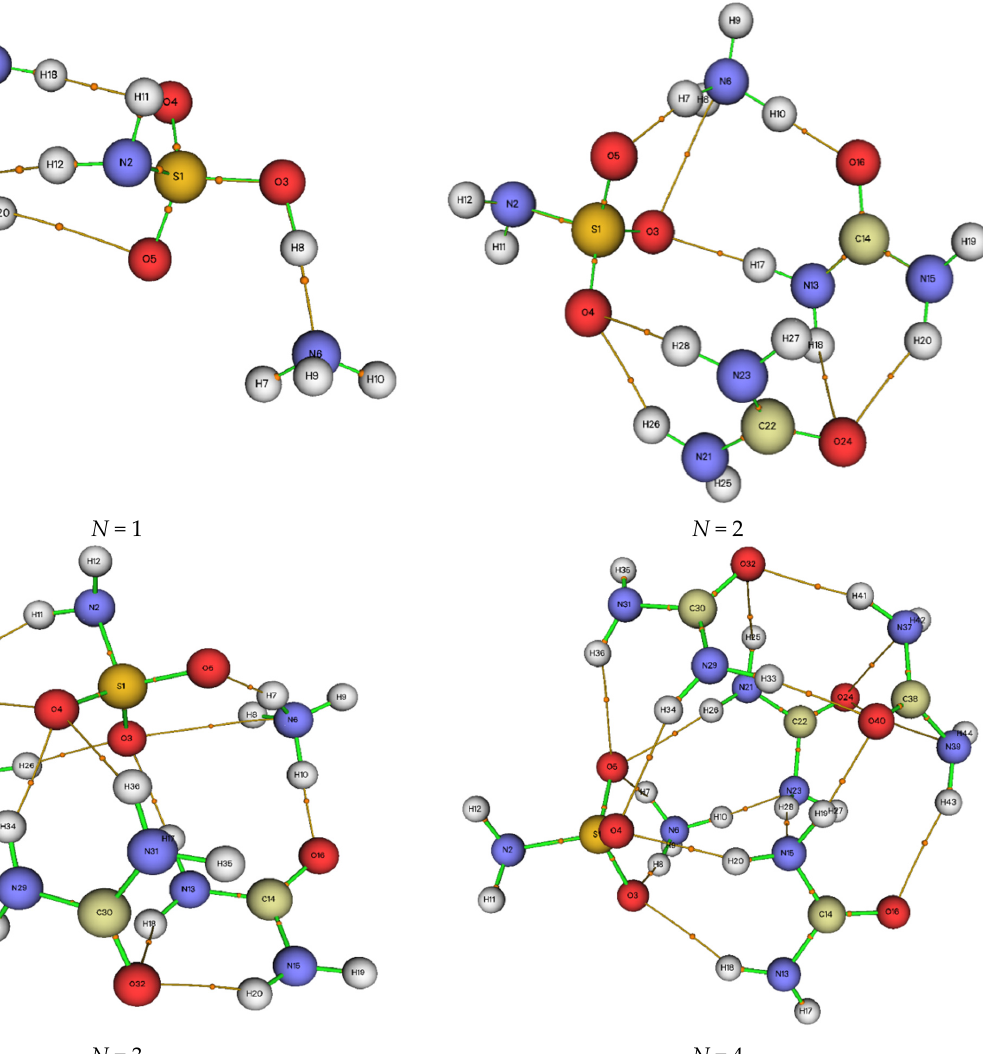
Figure 9. AIM graphs calculated for the compounds with different urea contents.